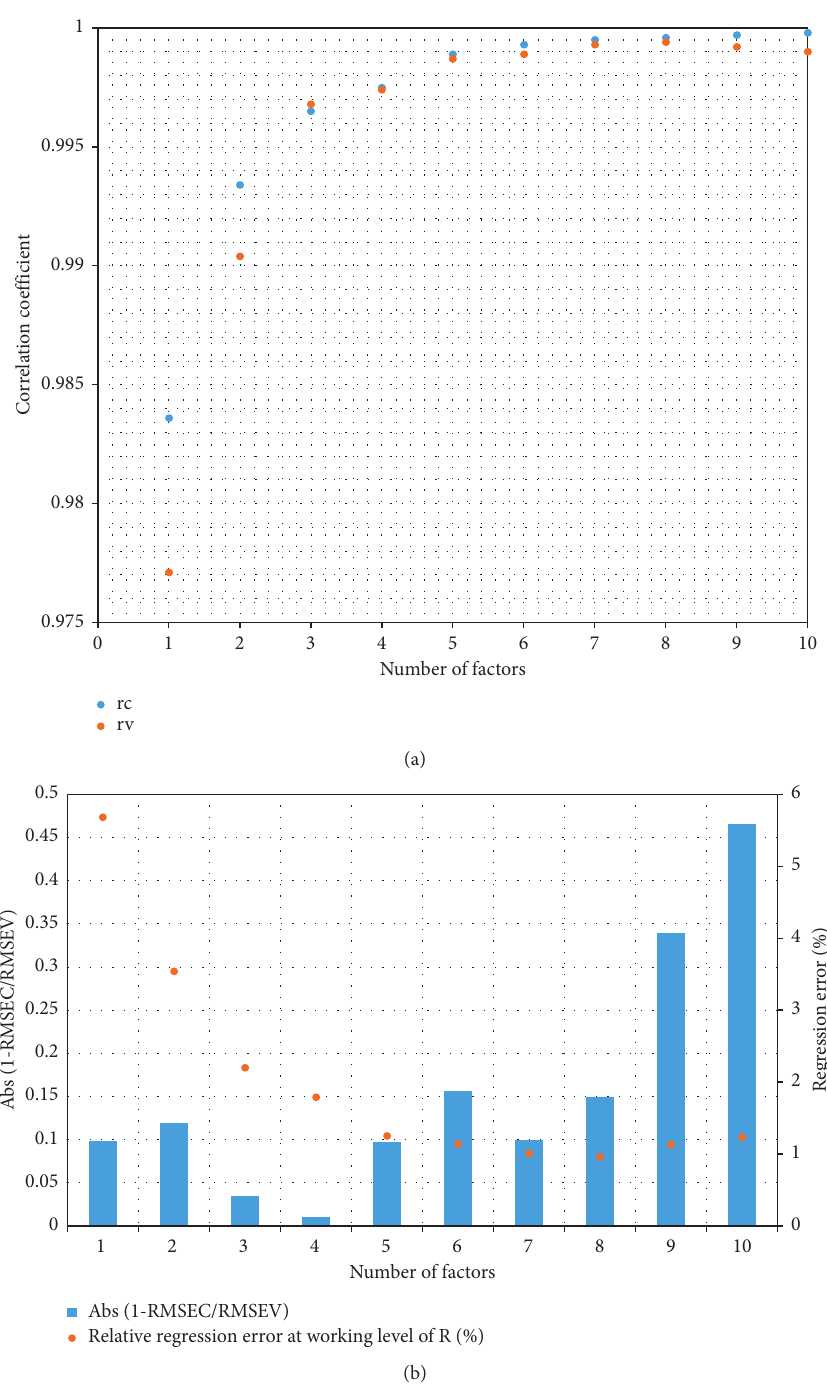
Figure 2: Selection of factor number for calibration model: (a) variation of correlation coefficient and (b) variation of the difference between RMSEC and RMSEV and variation of relative error due to linear regression at R value of about